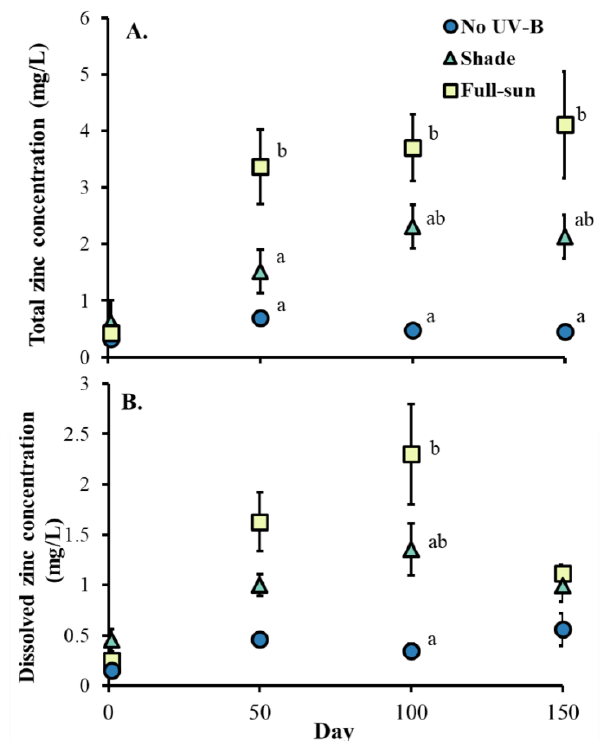
Figure 1. Least square means (± SE) for ( A ) total and ( B ) dissolved zinc concentration in water from tires exposed to UV-B radiation conditions that mimicked full-sun, shade, and no UV-B radiation conditions on days 50, 100, 150. Significant pairwise comparisons within each day are indicated by different letters beside markers ( p < 0.05). No letters indicate no significant pairwise differences.